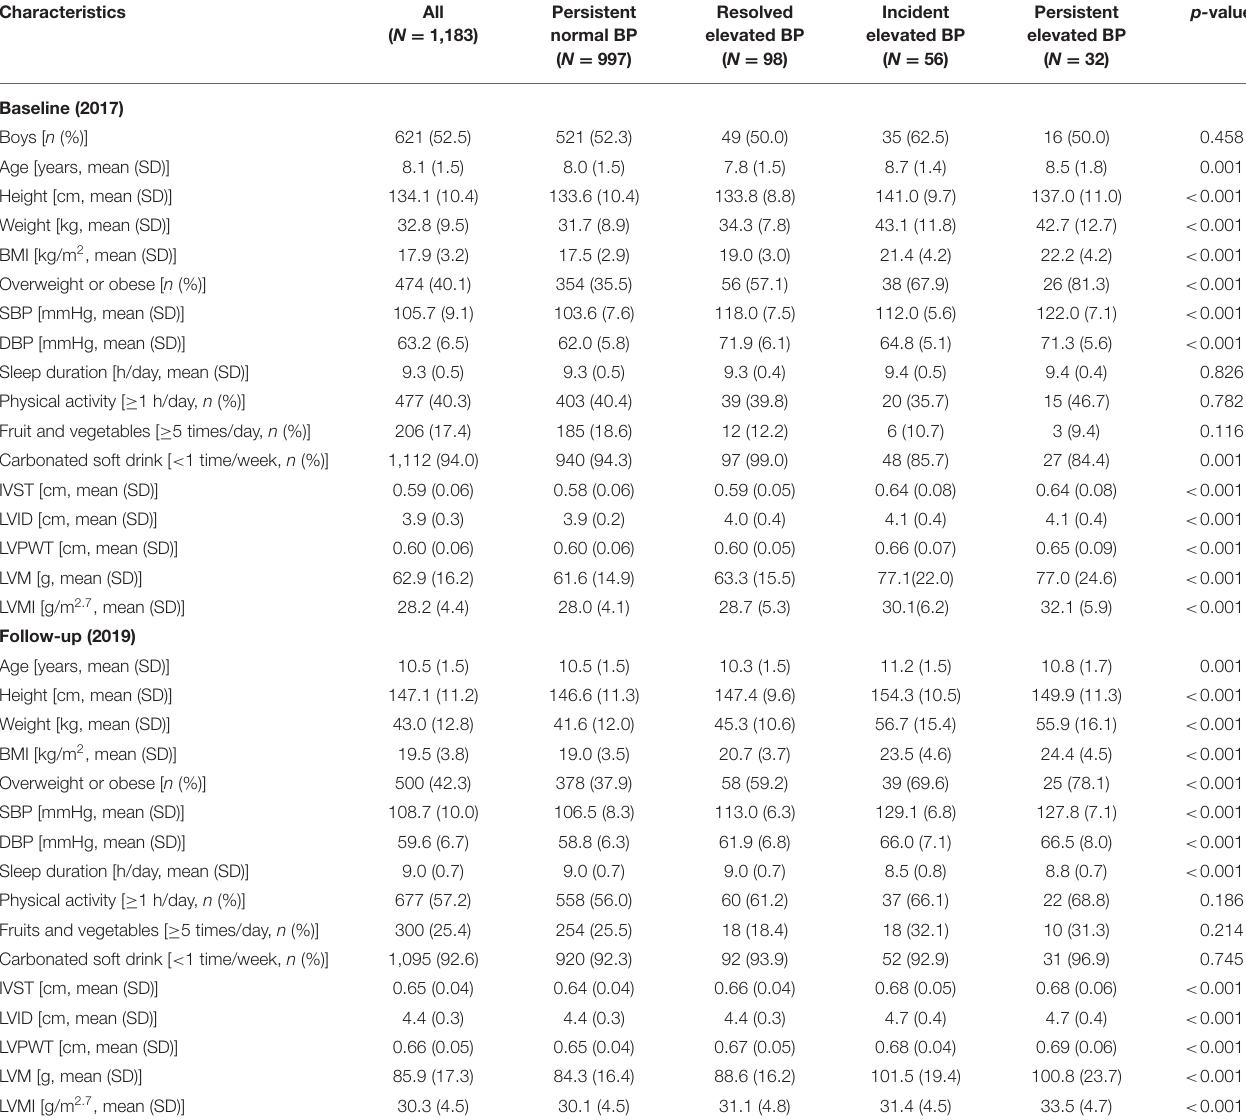
Chi-square test was performed to assess the differences of categorical variables between four BP status groups. Analysis of variance was performed to assess the differences of continuous variables between four BP status